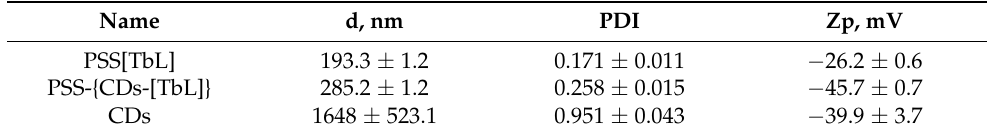
Table 1. The average hydrodynamic diameters (d), electrokinetic potential values ( ζ ) and polydisper-